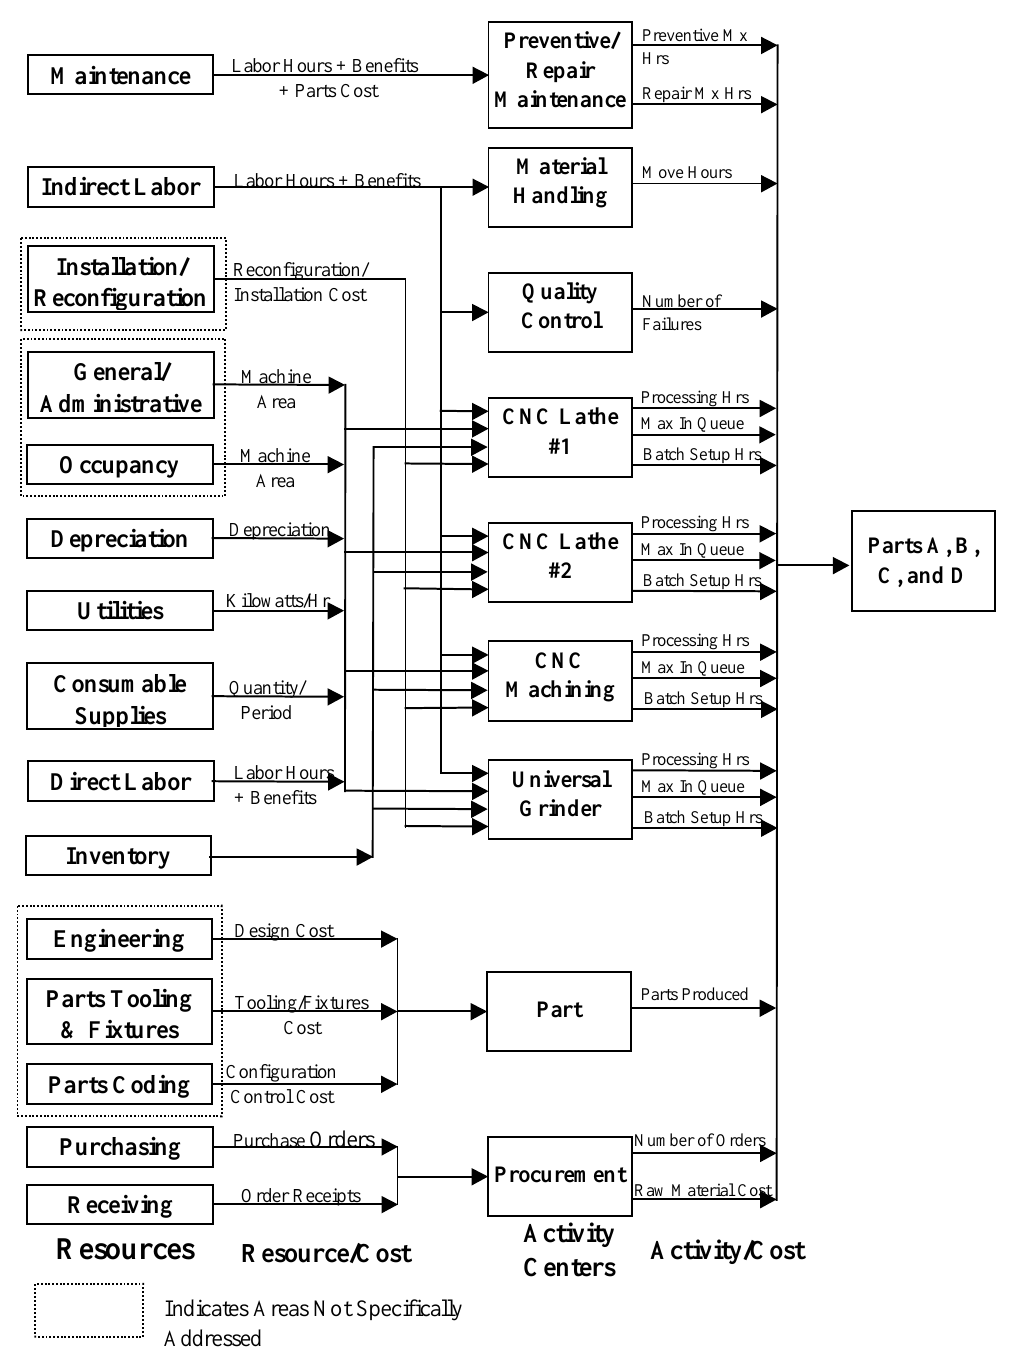
Figure 2. “Activity-based costing representation for the manufacturing cell”. Figure 2 provides a generalized activity-based costing depiction for the example manufacturing cell. The resources and activity centers that are shown are not meant to be all inclusive but simply representative of a typical manufacturing cell. Areas highlighted by a dotted box were not addressed as part of this research.